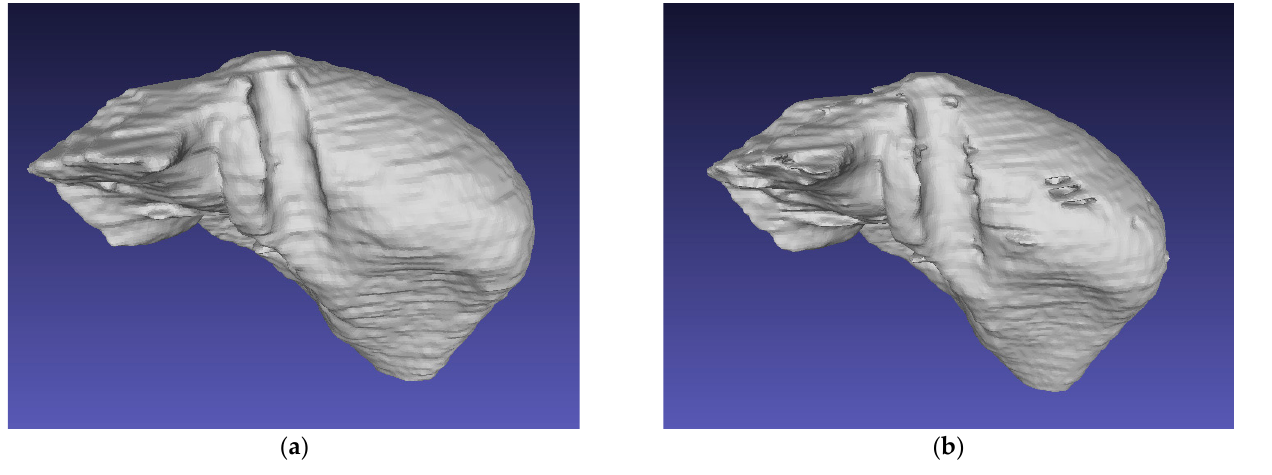
Figure 10. 3D visual liver labeled by specialist radiologists (a) and segmentation results with a proposed model (b) (patient 16 in the LiST dataset).